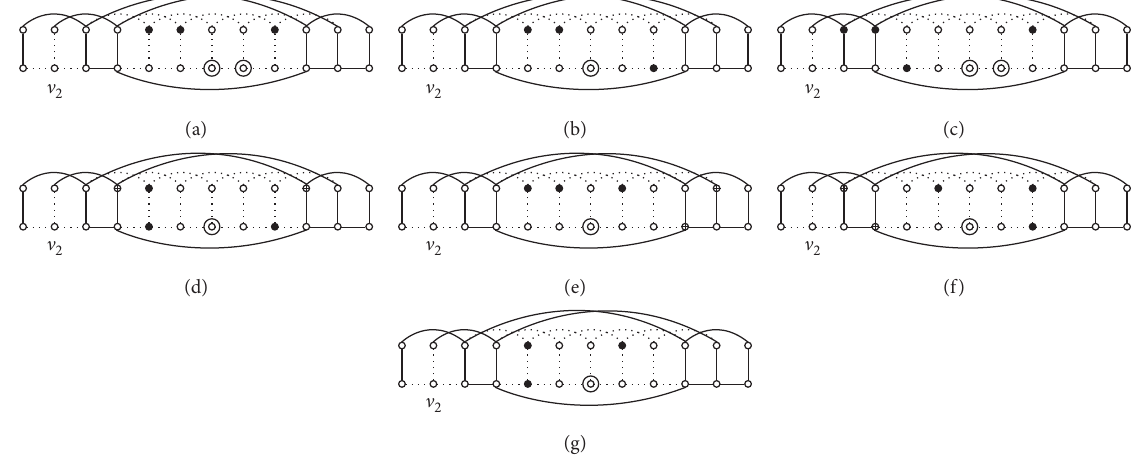
Figure 3: The seven possible cases of S in Subcase